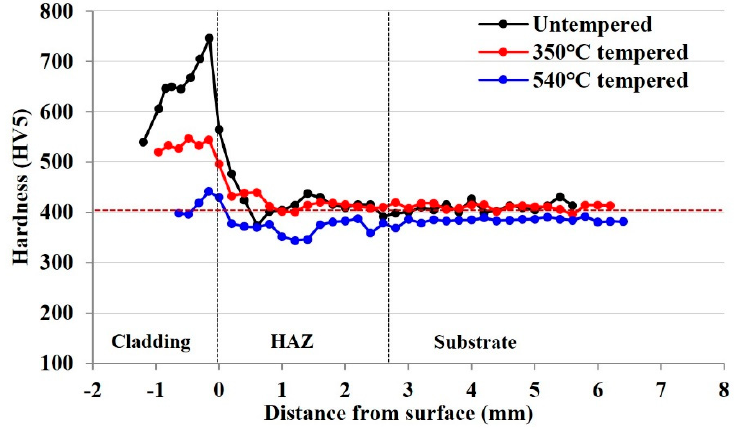
Figure 8. Transverse hardness profiles of the 415SS cladding in the untempered state and after 350 °C and 540 °C heat treatments.